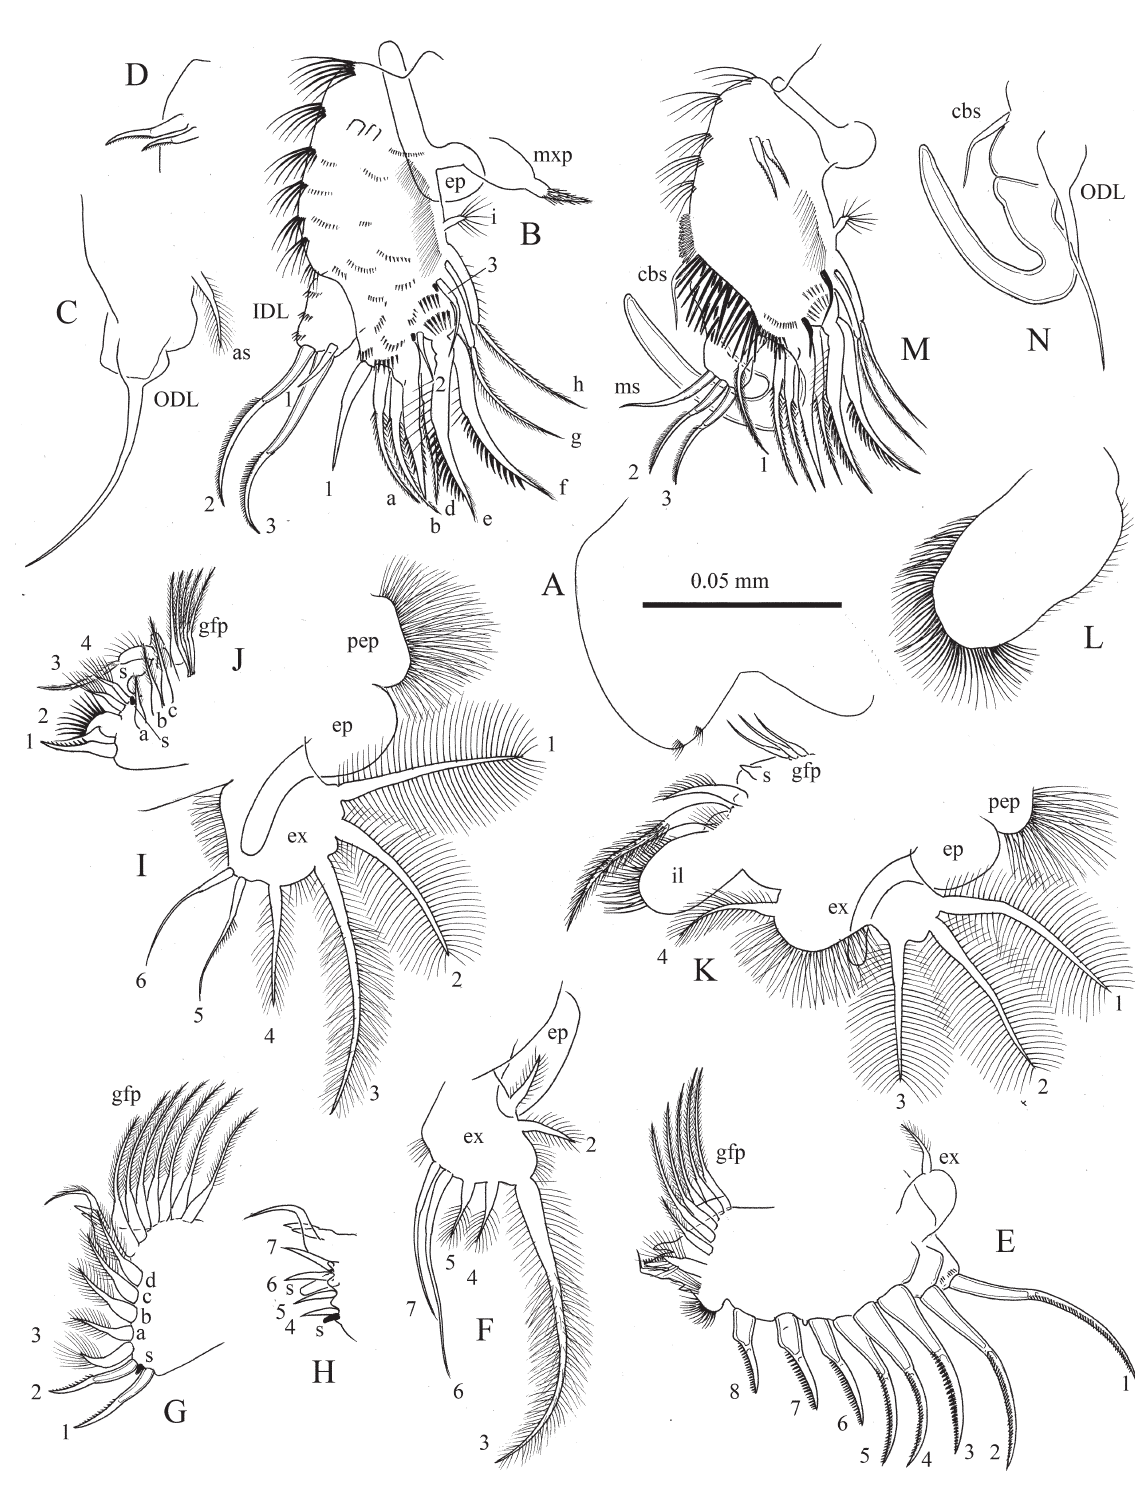
Fig. 2. Flavalona costata (Sars, 1862) comb. nov., Randsfjorden Lake, Norway. A–L . Labrum and thoraciс limbs of parthenogenetic ♀. A . Labrum. B . Limb I. C . ODL of limb I. D . Ejector hooks of limb I. E . Limb II. F . Exopodite of limb III. G–H . Inner portion of limb III. I . Exopodite of limb IV. J . Inner portion of limb IV. K . Limb V. L . Limb VI. M–N . Thoracic limb I of adult